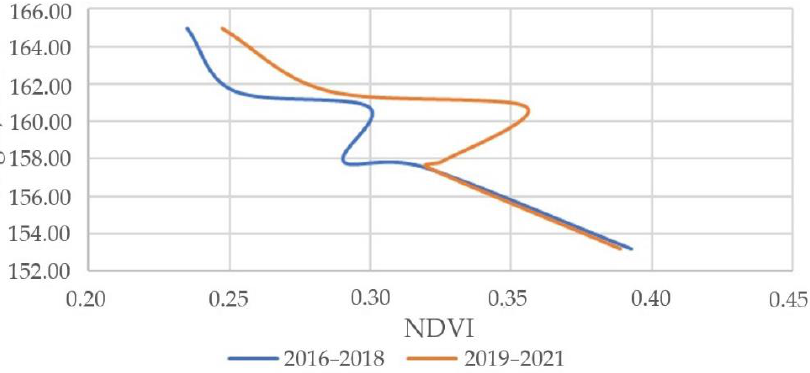
Figure 8. Change of NDVI values for the period from 2016 to 2018 and from 2019 to 2021 from the foot of the slope to the top along profile AB.